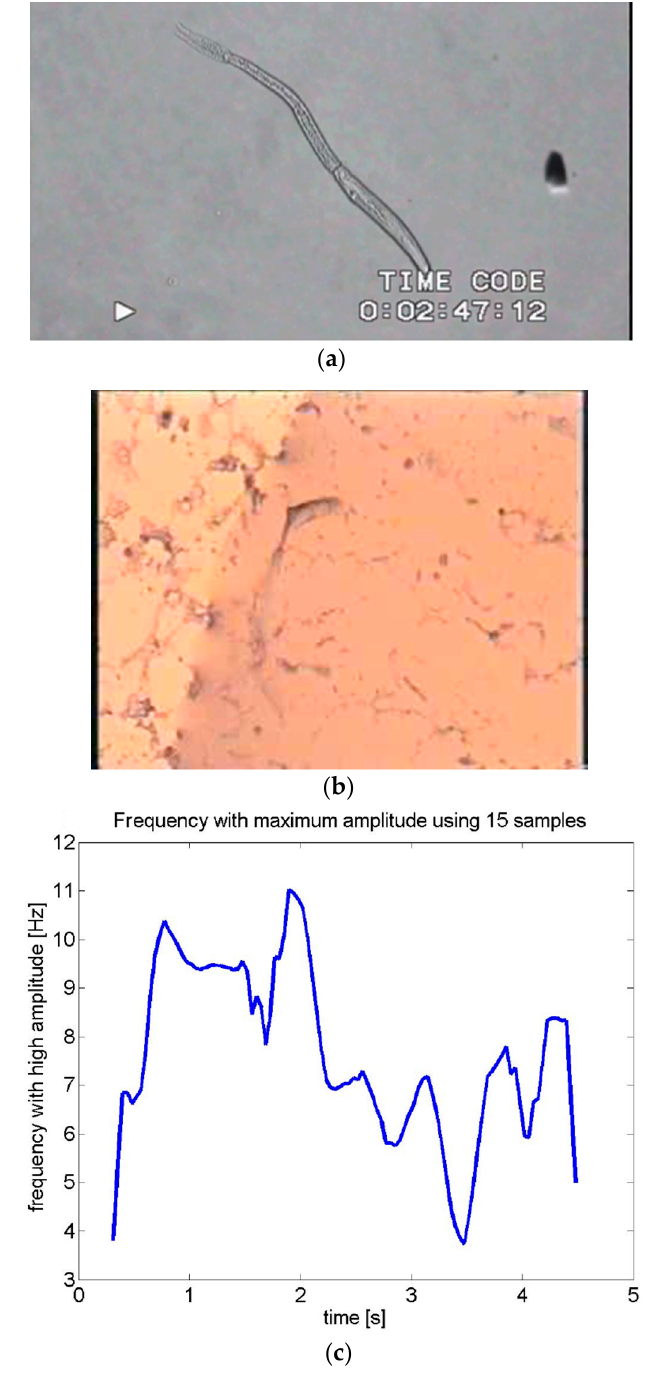
Figure 3. ( a ) Schistosoma mansoni cercaria in water. The different motility behavior of the tail and the head parts is seen. The tail will be lost upon penetration of host skin. The frontal part will invade the skin of host and transform into schistosomulum. The recording frame rate 15.63 FPS is too slow to allow for adequate signal processing. ( b ) Trichobilharzia cercaria attaches to skin-lipid coated microscope slide and attempts penetration. The wiggling motility of Trichobilharzia cercaria was recorded at a frame rate of 15.63 FPS. Original magnification of video recordings was 100×. ( c ) Analysis of cercarial motion seen in b ; variation of frequency (Hz) over time of 5 s. As it is possible to record a maximum of about 7 or 8 Hz, the recording speed should be at least 2× the frequency maximum. We estimate that to record cercarial motion, at least 100 FPS is needed.